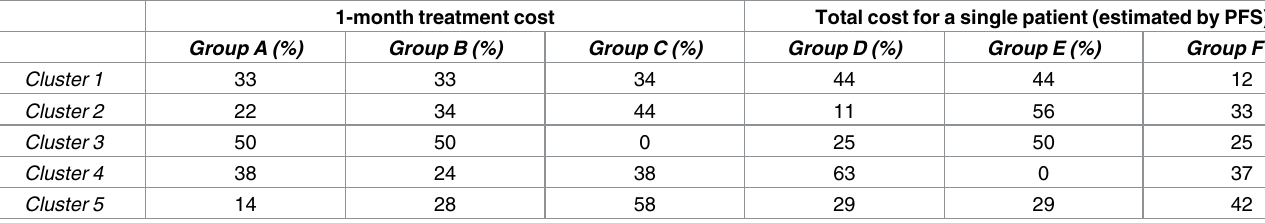
Table 4. Distribution of costs within the 5 clusters based on TI.